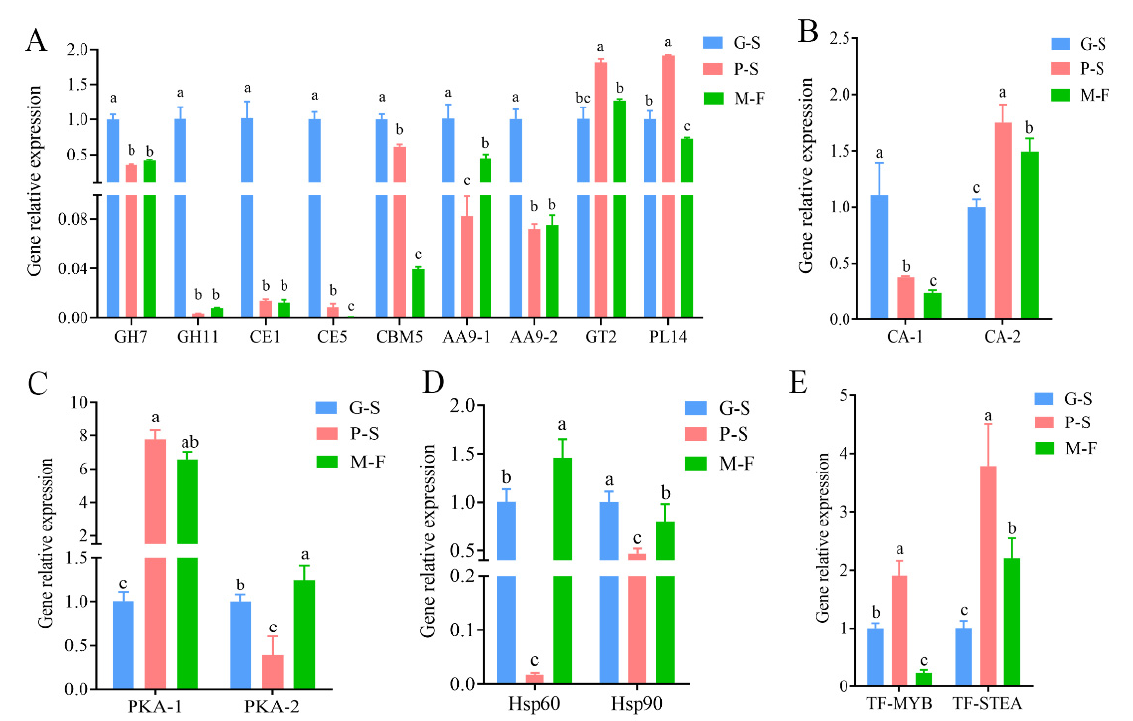
Figure 7. Validation of the gene expression levels of specific enzymes: ( A ) ten differentially expressed CAZyme genes (i.e., GH7 , GH11 , CE1 , CE5 , CBM5 , AA9-1 , AA9-2 , GT2 and PL14 ) in the growth and development stages; ( B ) two differentially expressed carbonic anhydrase genes (i.e., CA-1 and CA-2 ) in the growth and development stages; ( C ) two differentially expressed PKA protein kinase genes (i.e., PKA-1 and PKA-2 ) in the growth and development stages; ( D ) two differentially expressed heat shock protein genes (i.e., hsp60 and hsp90 ) in the growth and development stages; ( E ) two differentially expressed transcription factor genes (i.e., TF-MYB and TF-STEA ) in the growth and development stages. All data are presented as the means ± standard deviations (SDs) of three independent experiments. Bars with different letters are significantly different at p < 0.05 according to Duncan’s multiple range test.